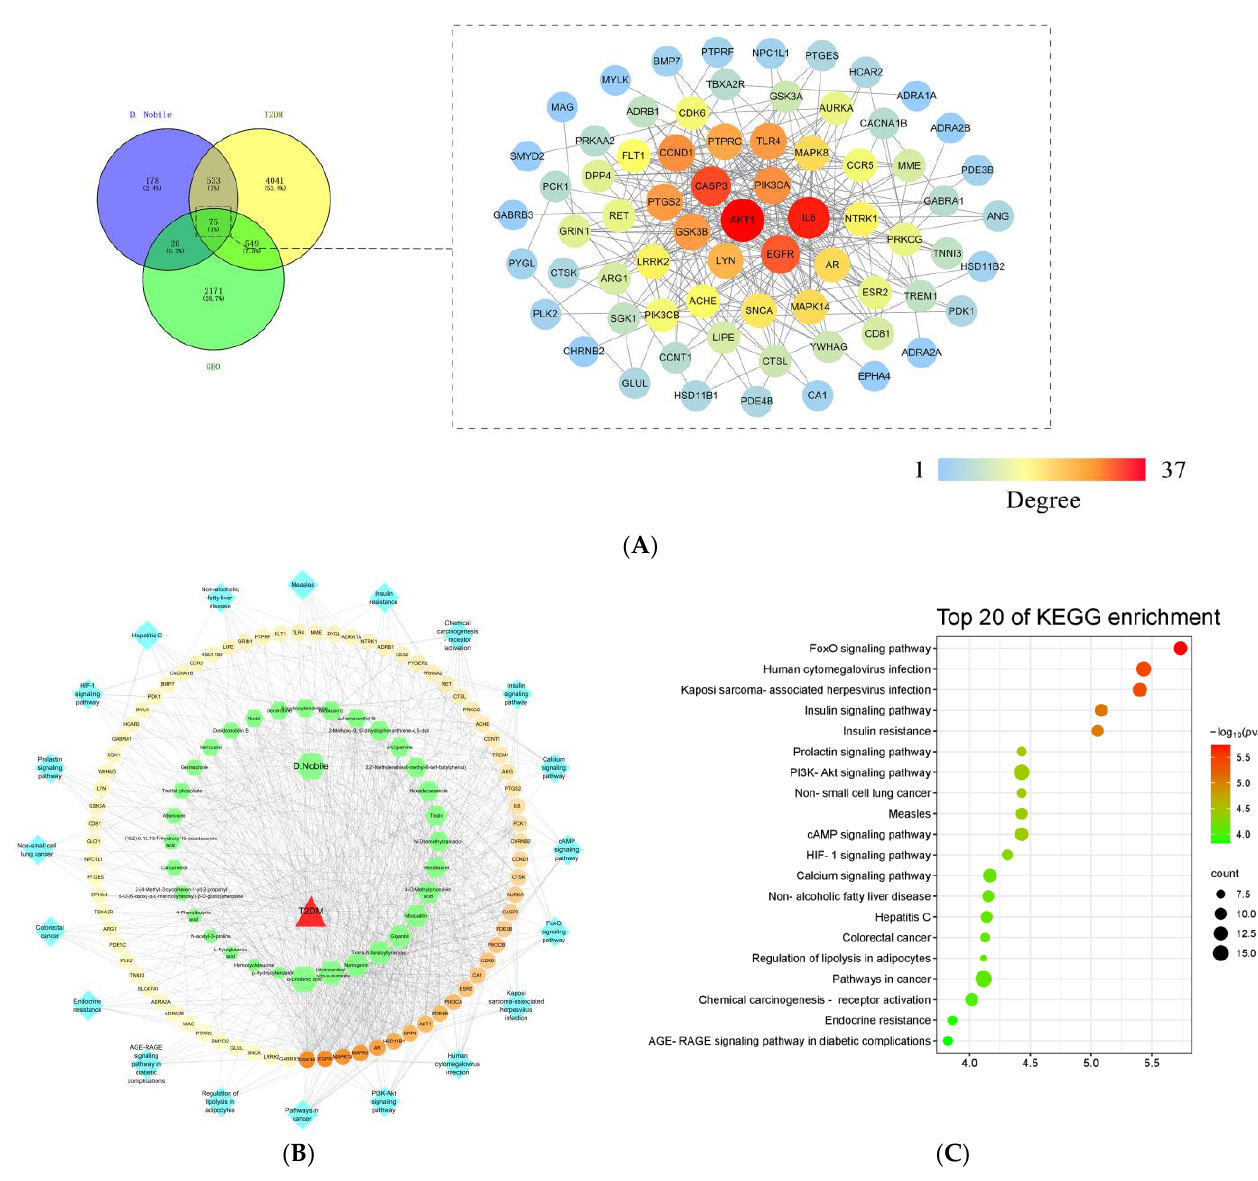
Figure 16. PPI network ( A ), “Herb-Compounds-Targets-Pathway-Disease” network ( B ), and bubble diagram of the KEGG enrichment analysis ( C ) of D. nobile in the treatment of T2DM after the network pharmacological analysis.